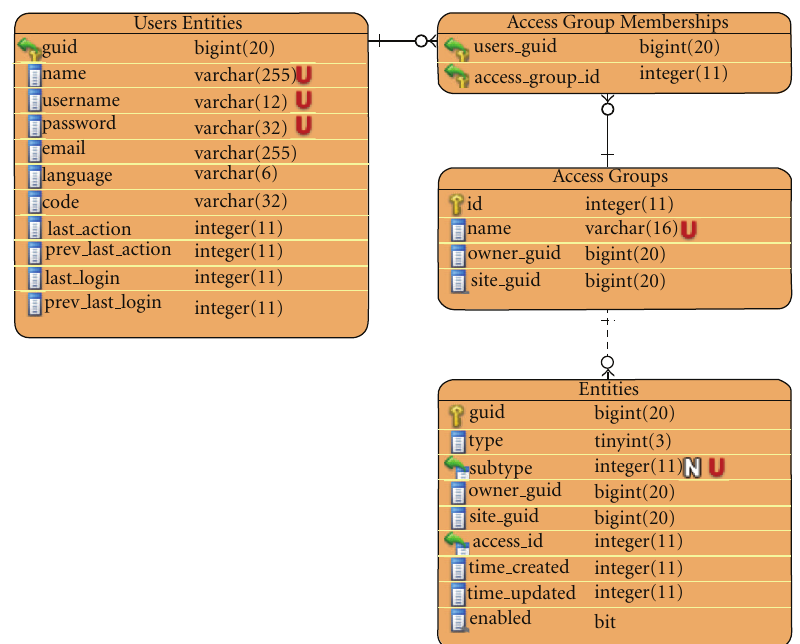
Figure 12: The “Access Groups” and “Access Group Membership” tables for the application of access controls to entities.